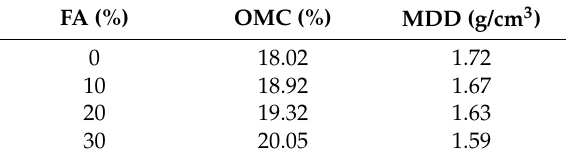
Table 6. The effect of FA stabilization of loess on compaction test with varying FA